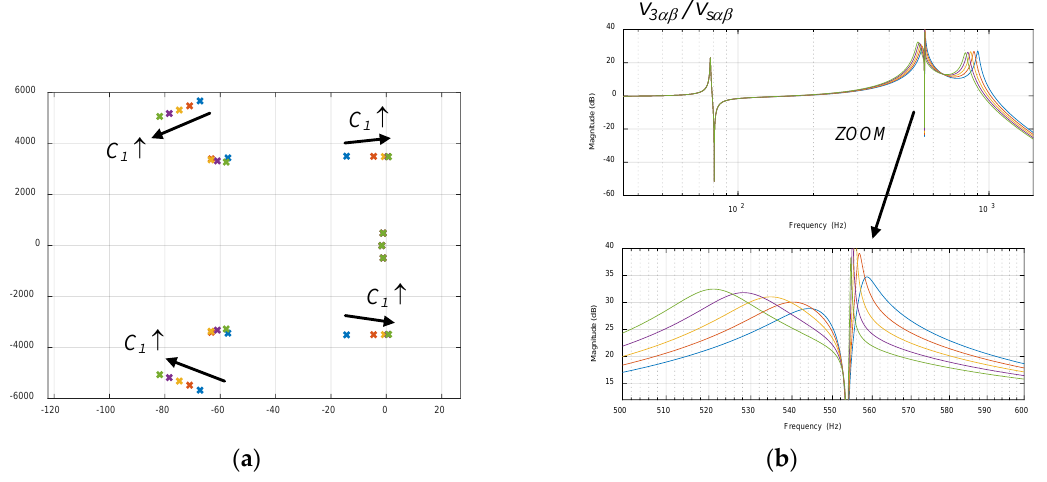
Figure 13. Dominant poles and Bode plots of the voltage at the Pcc with different C 1 (multiplied by factors (1 1.1 1.2 1.3 1.4) from its initial value) values of the AC grid impedance. Active resistance is constant R v 1 = 1.51 k Ω programmed at 550 Hz. ( a ) Dominant poles of the system, ( b ) Bode plot of v 3 αβ ( s )/ v sαβ ( s ).